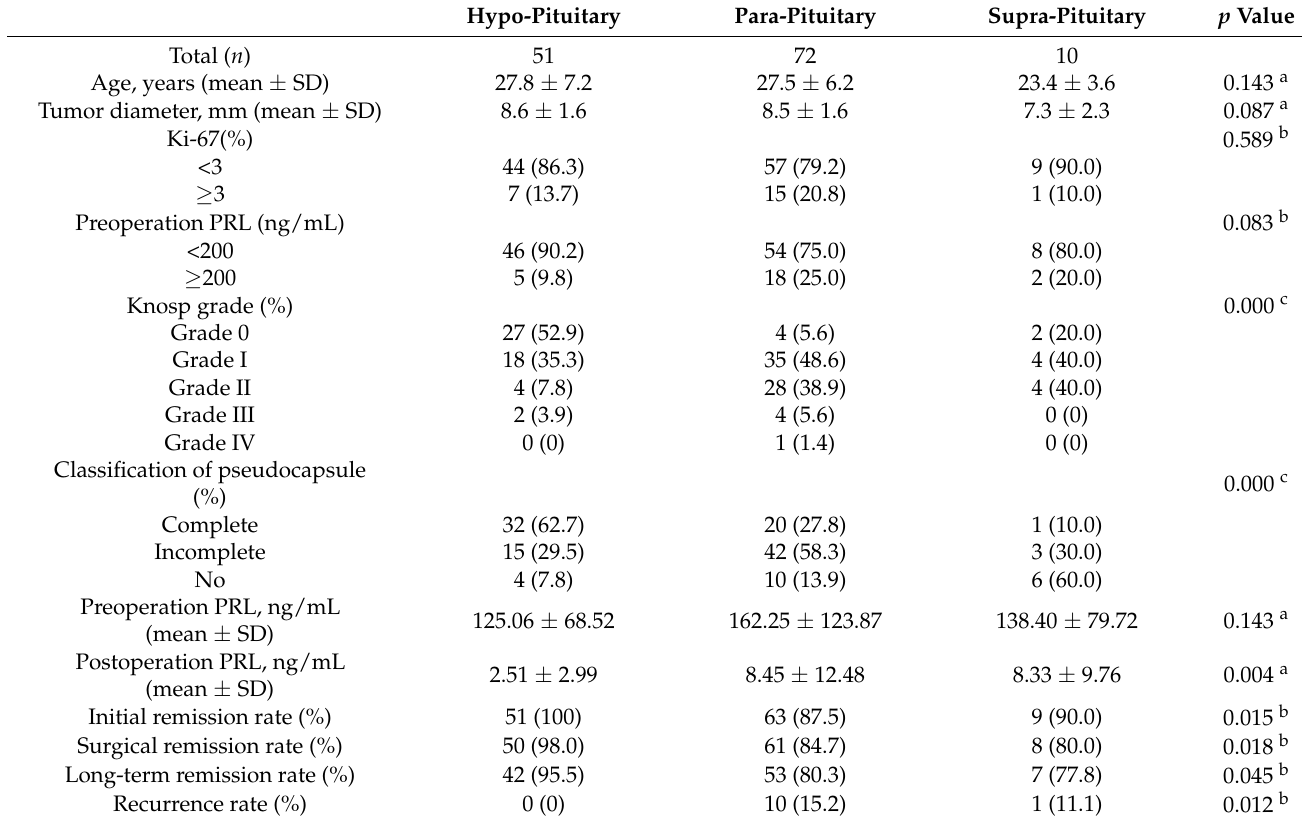
Table 7. Effect of treatment and prognosis for 133 female patients with microprolactinoma, according to the locational relationship between tumor and